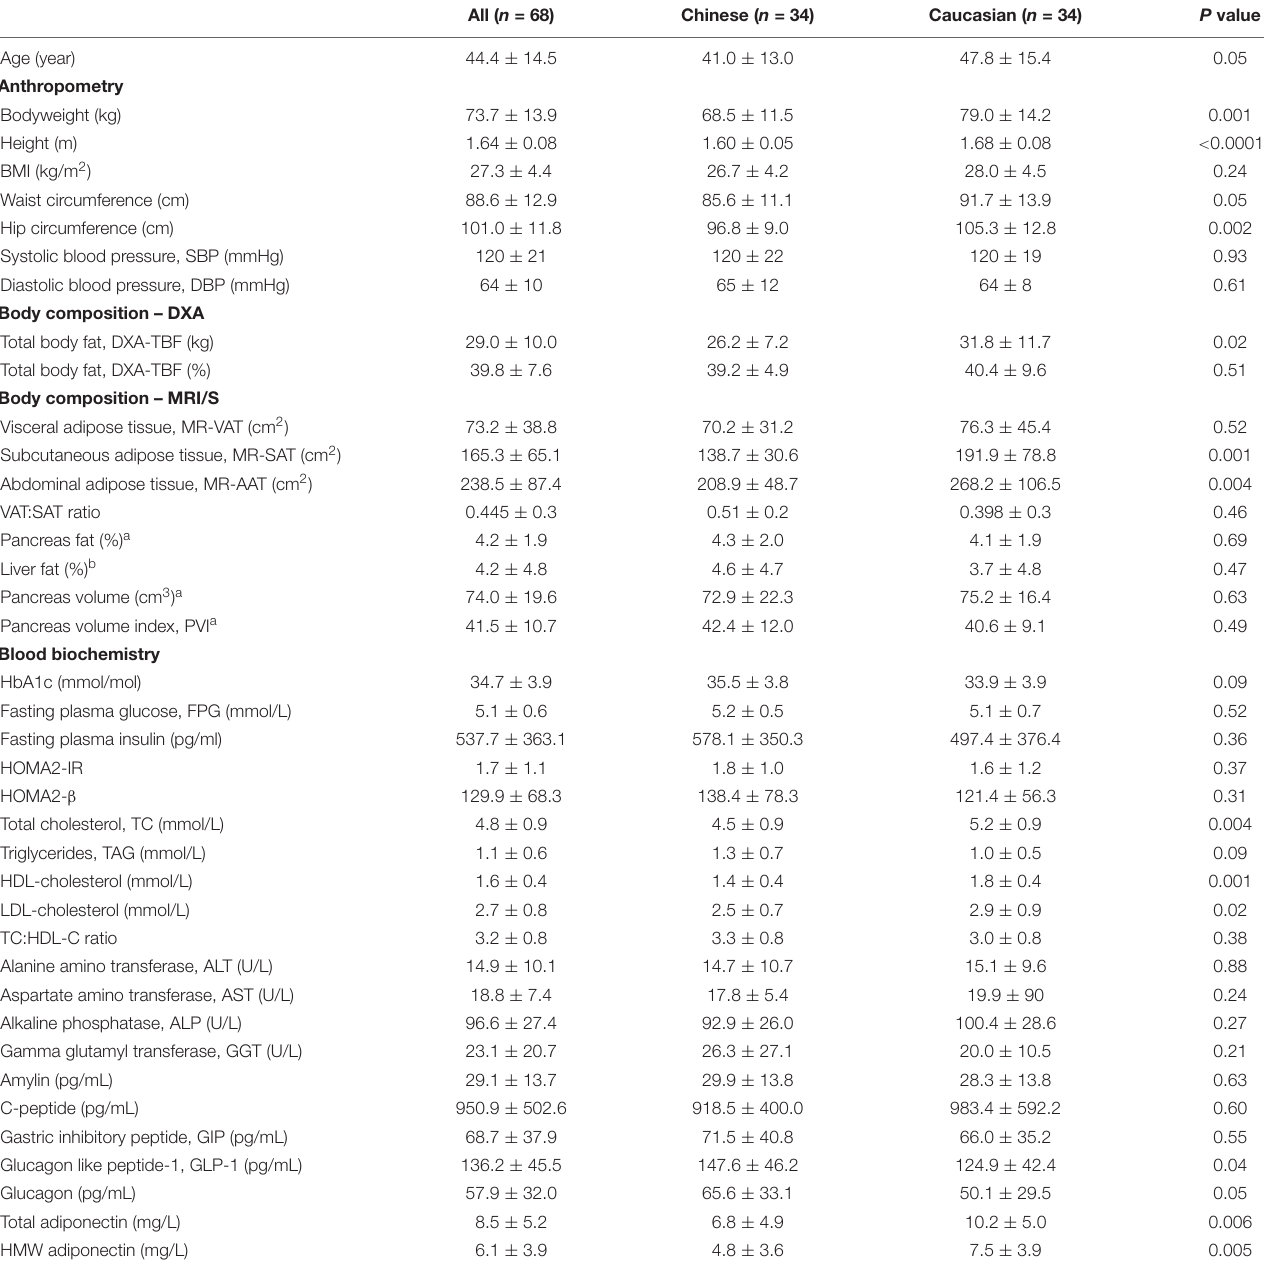
TABLE 1 | Summary of metabolic risk factors of women enrolled in the TOFI_Asia MR